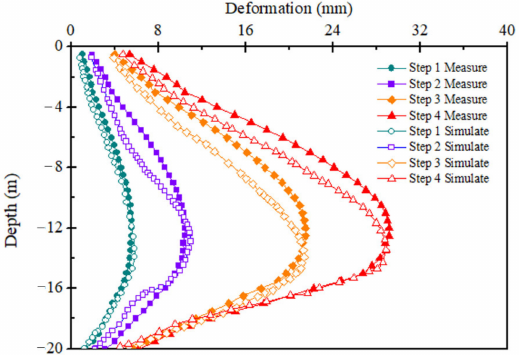
Figure 10. Horizontal displacement of the diaphragm wall through